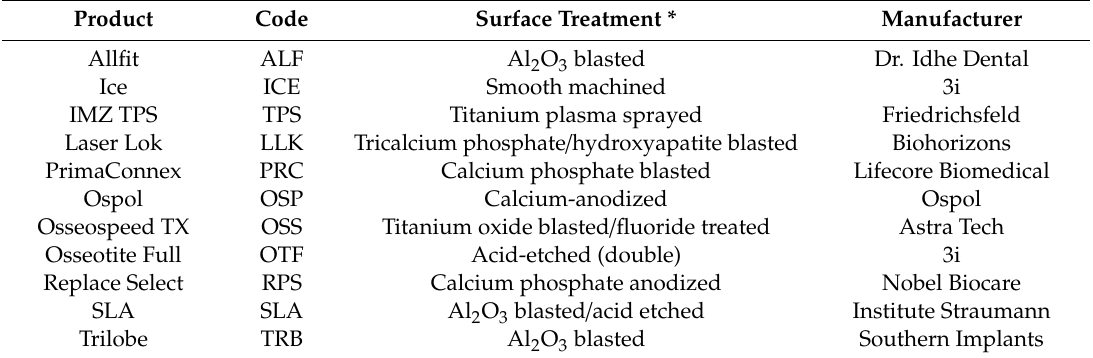
Table 2. List of commercially available implants tested. Table reproduced with permission from [69].